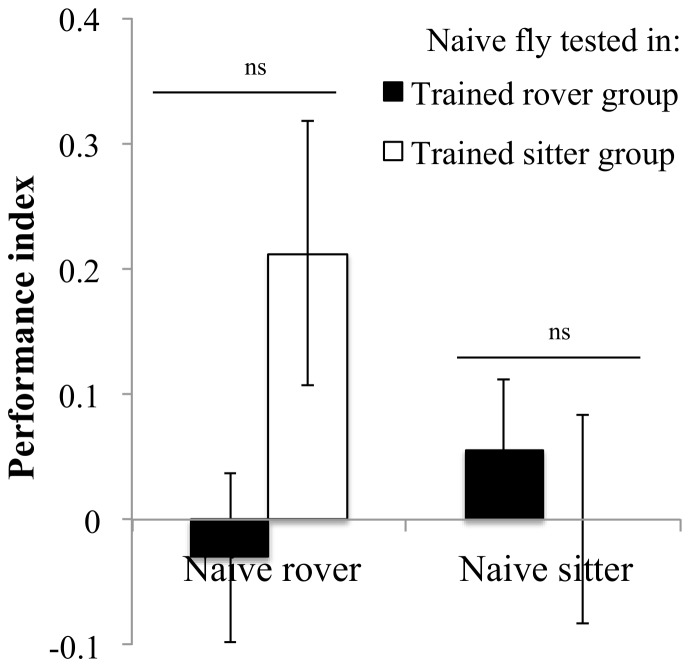
Performance of individual naïve flies tested in groups of conditioned flies.Positive PI indicates that the focal naive fly avoided the odour that the group was trained to avoid. Rover: rover group: PI = −0.03±0.1 N = 12 PI; sitter group: PI = 0.21±0.07 N = 12 PI. Sitter: rover group: PI = 0.05±0.08 N = 12 PI; sitter group: PI = 0±0.07 N = 12 PI. Error bars represent ±SEM. Comparison between treatments. ns: P>0.05; *: P<0.05; **: P<0.01; ***: P<0.001.